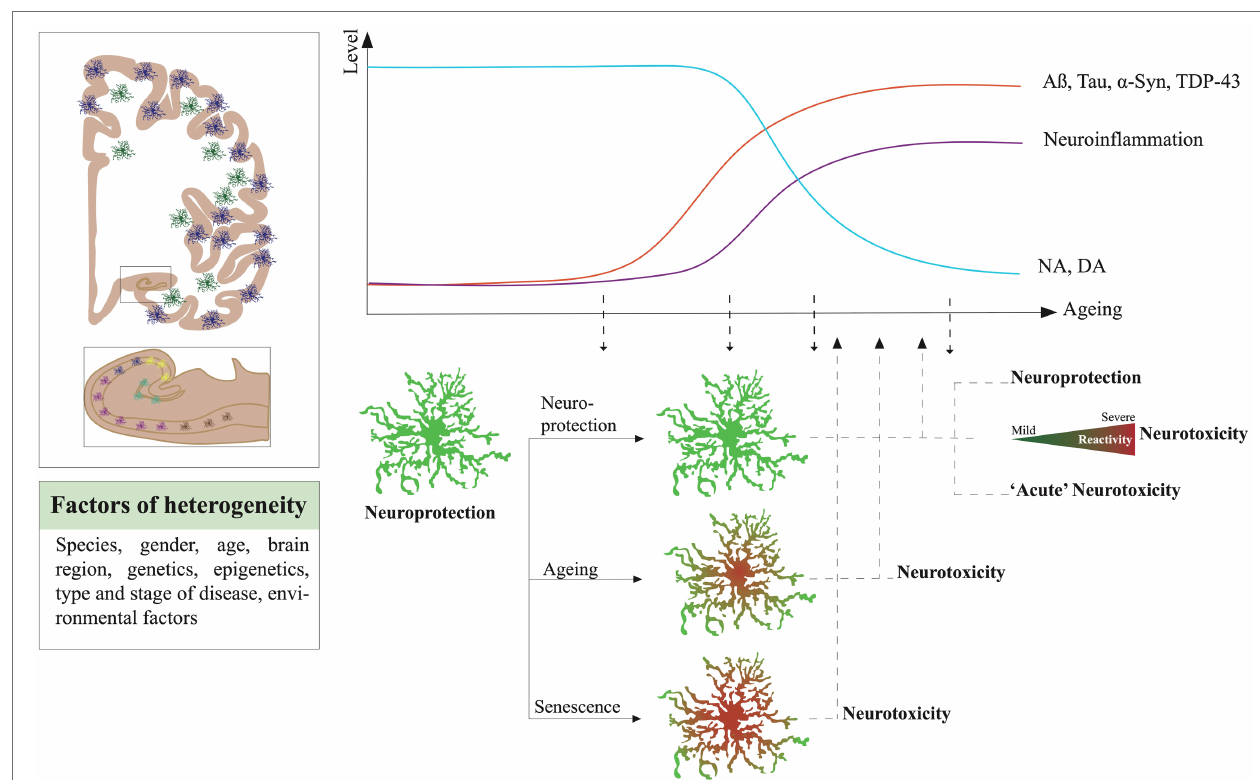
FIGURE 2 | Hypothetical roads to astrocyte neurotoxicity in the context of neurodegenerative diseases (NDDs) and ageing. The heterogeneity of astrocyte response and change depends on numerous factors, such as the species, gender, age, anatomic localization, genetics and epigenetics, their micro-environment, and the type and stage of the disease. In NDDs, one or several subgroups of astrocytes could lose their neuroprotective function and become neurotoxic. Many factors could impact their transformation into toxic cells. The effect of ageing could prime them to maladaptive responses, cellular senescence would turn them detrimental to their surroundings, pathological protein inclusions [A β , tau, α -synuclein ( α -Syn), and TAR DNA-binding protein 43 (TDP-43)], neuroinflammation and neurotransmitter concentration, and activation of immune cells would condition their shift to toxic thereby enhancing their detrimental features. Neurotoxic astrocytes would then contribute disease